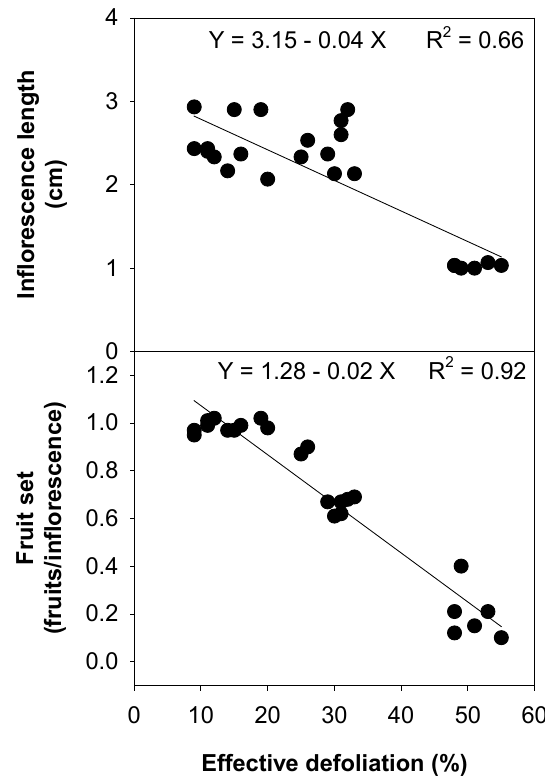
Figure 8. Relationships between effective olive tree defoliation caused by peacock eye with inflorescence lengths and fruit set. Each value represents the average of all the combinations of three factors (site, pruning, portion of